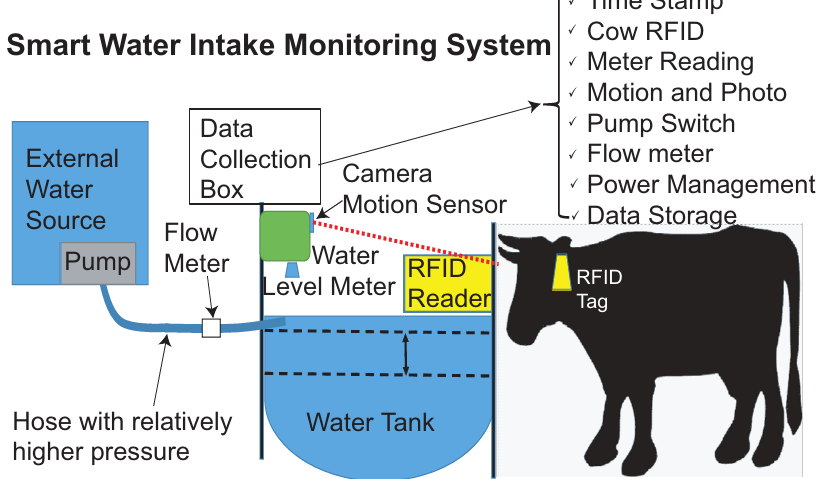
Figure 1. The proposed smart water intake monitoring system with multiple sensors and data